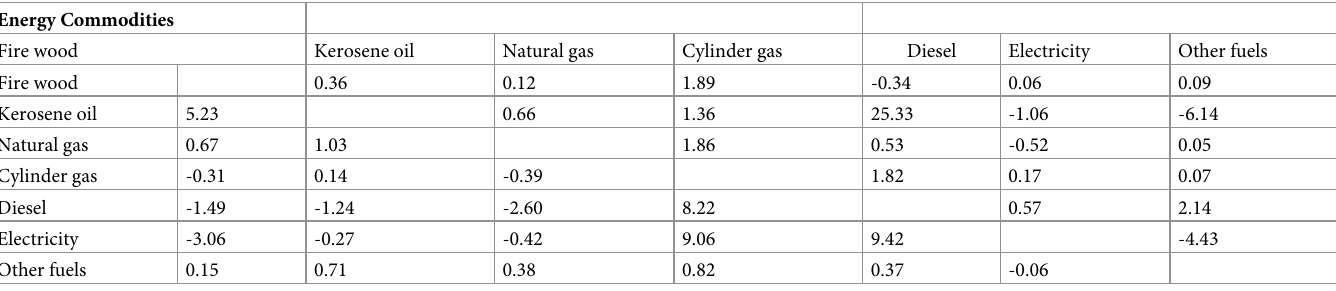
firewood, and other fuels are higher than compensated which indicates these are normal goods, while the compensated elasticity for cylinder gas and electricity is greater than uncom- pensated which shows that these are inferior, but for the kerosene oil and diesel the elasticities are same in magnitude which indicates that for these items there is less share of income. Table 6 presents the uncompensated cross-price elasticity of LA-AIDS. Cross price elastici- ties of Firewood with respect to other six energy commodities are positive signifying gross sub- stitute except for diesel for which firewood is complimentary due to negative elasticity. The uncompensated cross-price elasticity of kerosene oil is positive for firewood, natural gas, Cyl- inder gas, and Diesel and shows substitutes while w.r.t electricity and other fuels are negative and show complementary goods. Natural gas elasticities with respect to the other six energy commodities are positive signifying gross substitutes except for electricity for which natural gas is a compliment. Cylinder gas is a substitute for Kerosene oil, Diesel, other fuels, and elec- tricity, while cylinder gas is complimentary for Fire-wood and Natural gas. Diesel is compli- mentary for firewood, kerosene oil, and natural gas while Diesel is a substitute for other fuels, electricity and cylinder gas. The cross-price elasticity of electricity shows that it compliments all other energy items except cylinder gas and diesel. Other fuels are a substitute for all energy commodities except electricity. The compensated cross-price elasticities of LA-AIDS are presented in Table 7. The com- pensated cross-price elasticities are similar to the uncompensated cross-price elasticities. All the commodities are the same for each other as substitutes and compliments except other- fuels. Other-fuels cross-price elasticities from uncompensated LA-AIDS show complementar- ity for electricity, but from Compensated LA-AIDS other fuels are a substitute for electricity. Electricity is also a substitute for natural gas in compensated cross-price elasticities. Table 6. The uncompensated cross-price elasticities of